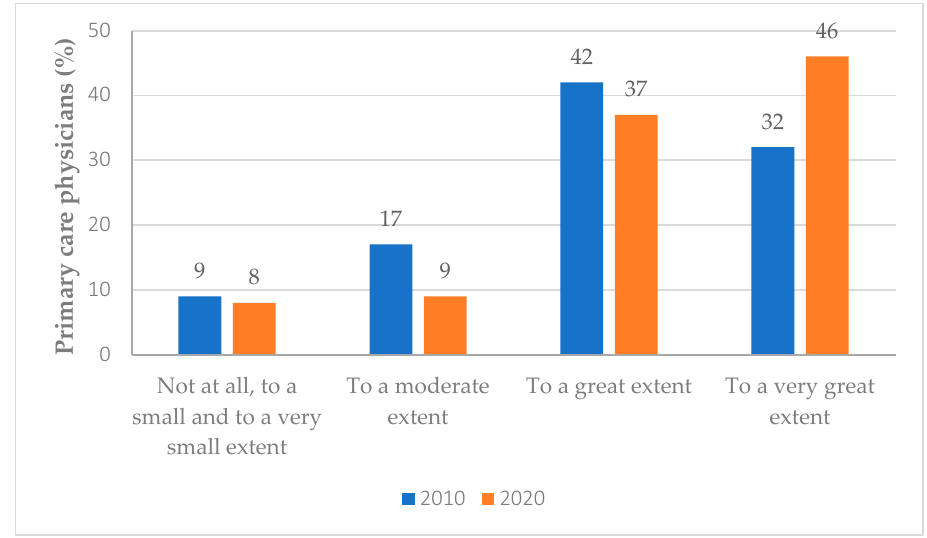
Figure 1. The extent of perceived shared responsibility of nurses by PCPs. Each Bar indicates weighted percentage of PCPs. Table 2. Comparison of PCPs perceptions on nurses’ actual involvement contributes to the quality of practice by survey year